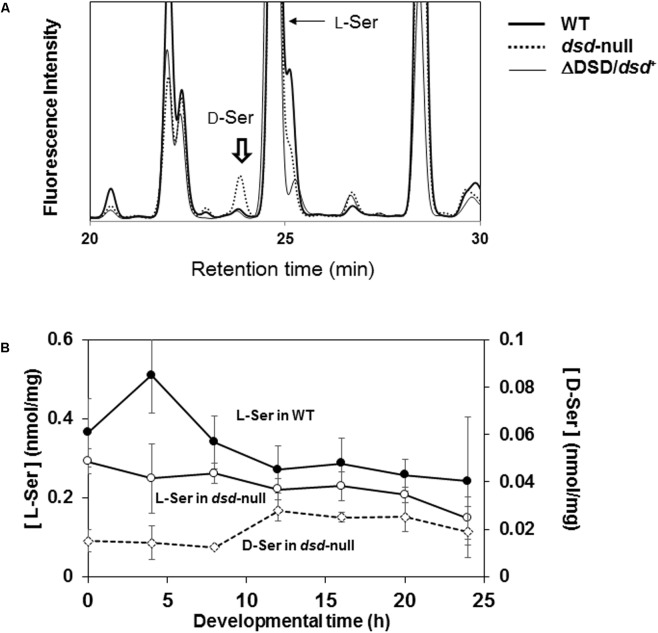
Effect of dsd knockout on the intracellular Ser concentration. Intracellular amino acid concentrations of WT, dsd-null, and ΔDSD/dsd+ were determined. (A) Representative chromatograms of intracellular amino acid analyses of WT, dsd-null, and ΔDSD/dsd+ of unicellular phase cells. Peak of D-Ser derivative is indicated by arrow. The small peaks at Retention Time 23.5 min in WT and ΔDSD/dsd+ samples are not for D-Ser derivative (because they were not decreased/disappeared by incubation with Dsd1p). (B) Intracellular D-Ser and L-Ser concentrations during development. WT and dsd-null cells were grown in HL5 medium and allowed to develop on a filter membrane by starvation. Cells were collected at different stages of development and the intracellular concentrations of D-Ser and L-Ser were quantified by HPLC. Intracellular D-Ser levels were under the detection limit in WT. Data are represented as the mean ± SD (n = 3).